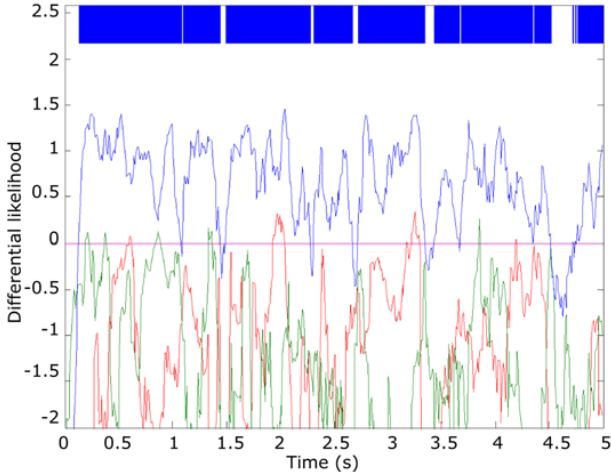
Figure 14. Result of the smoothed differential likelihood of “0560” sample.